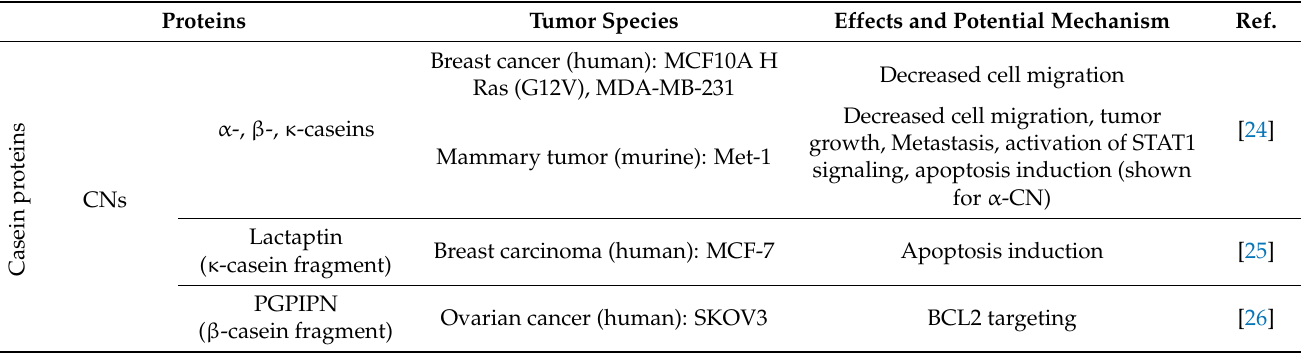
Table 1. Effects and potential mechanisms of milk proteins or their processed peptides with known antitumor activities against different tumor species shown by in vitro and in vivo experiments. Species are marked in brackets, respectively. Proteins Tumor Species Effects and Potential Mechanism Ref.